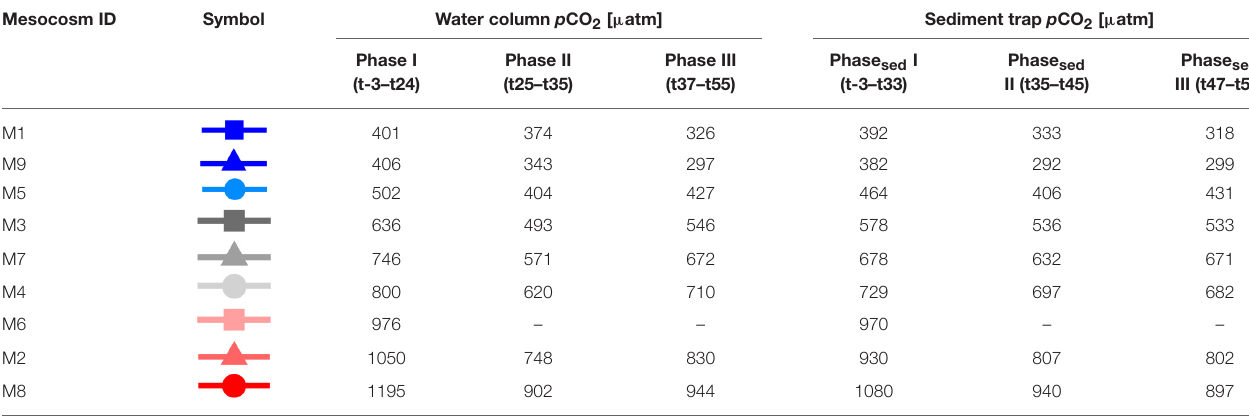
TABLE 1 | Average values for seawater p CO 2 for each experimental phase, defined in section Chlorophyll a and Experimental Phases. Mesocosm